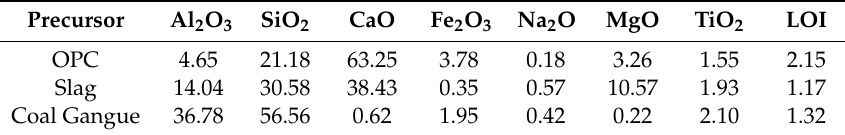
Table 1. Chemical composition of coal gangue and slag (wt %).